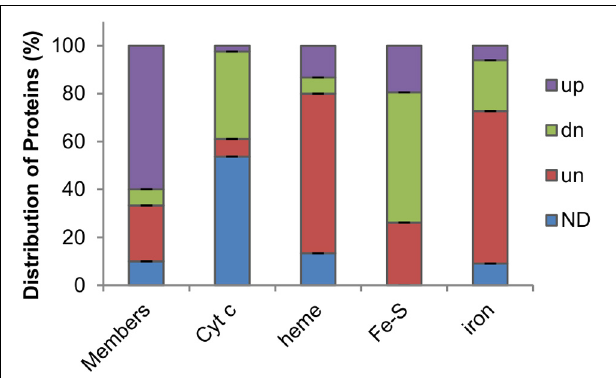
FIGURE 2 | Impacts of Fur loss on levels of Fur regulon members and iron proteins in S. oneidensis . Members, proteins whose coding genes carry a Fur-binding motif ranked in top 30. Cyt c , cytochrome c proteins. Heme, heme-containing proteins other than cyt c . Fe-S, proteins carrying any kind of Fe-S clusters. Iron, proteins that bind to and traffic iron or use iron as a cofactor. Up-regulated (up), down-regulated (dn), and unchanged (un) abundance (1.5-fold) in the fur mutant based on the proteomic data; ND, no